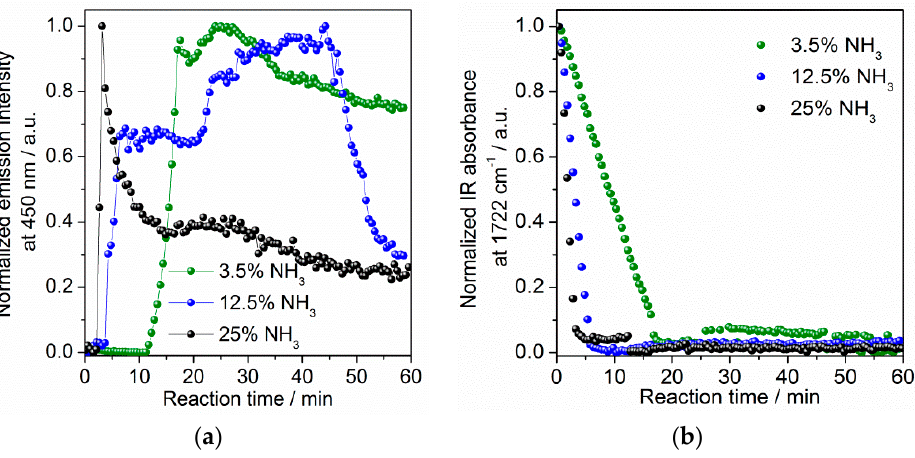
Figure 5. ( a ) Emission intensity at 450 nm and ( b ) infrared absorbance at 1722 cm − 1 for NH 3 concentrations of 25% (black dots), 12.5% (blue dots), and 3.5% (green dots). concentrations of 25% (black dots), 12.5% (blue dots), and 3.5% (green